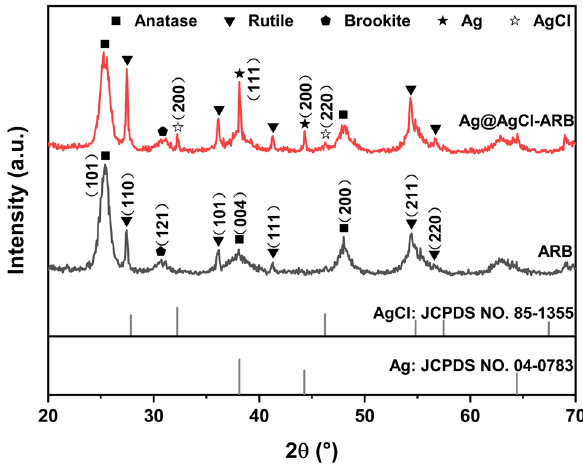
Figure 1: XRD patterns of the